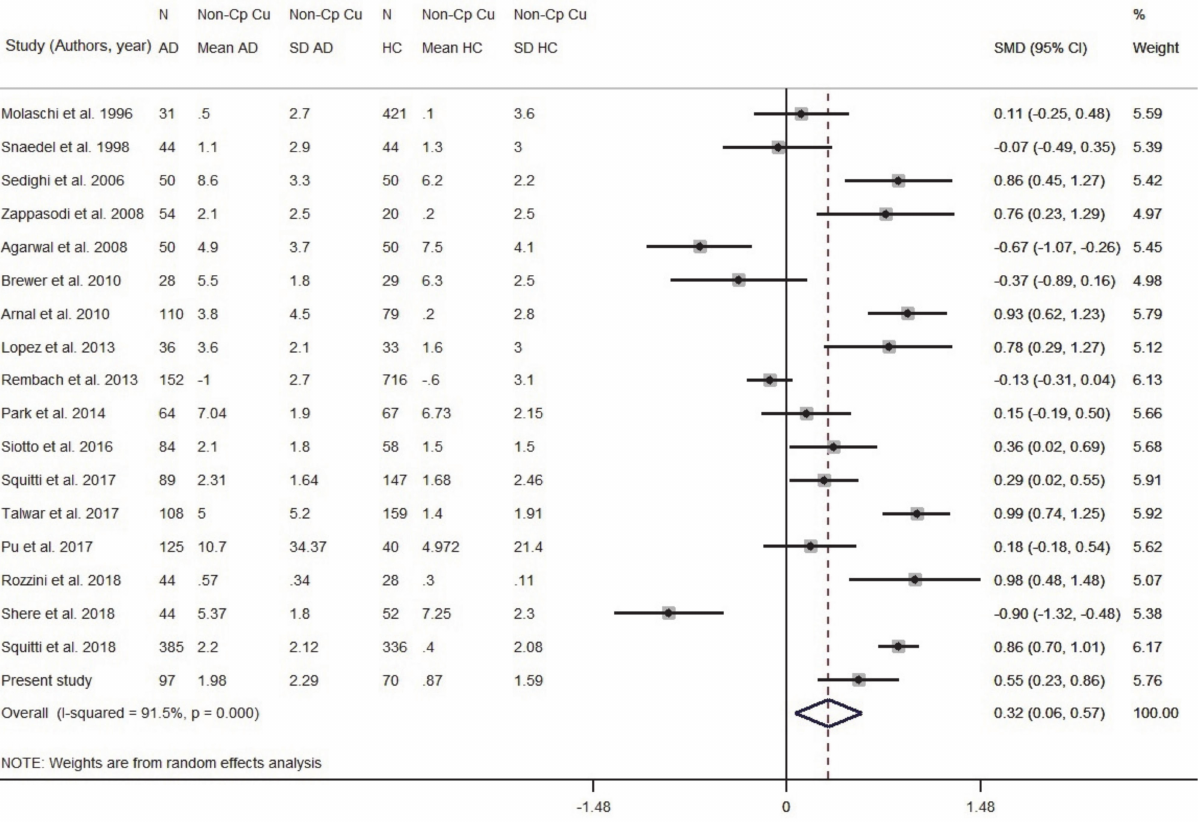
Figure 4. Standardized mean difference (SMD) computed from the studies on Non-Cp Cu( µ mol/L) in AD patients and HC subjects. SMDs between AD subjects and controls are represented by squares, whose sizes are proportional to the sample size of the relative study. The whiskers represent the 95% confidence interval (CI). The diamond represents the pooled estimate based on the random-effects model, with the center representing the point estimate and the width indicating the associated 95% CI. Abbreviations: PY, publication year; N, number; SD, standard deviation; HC, healthy